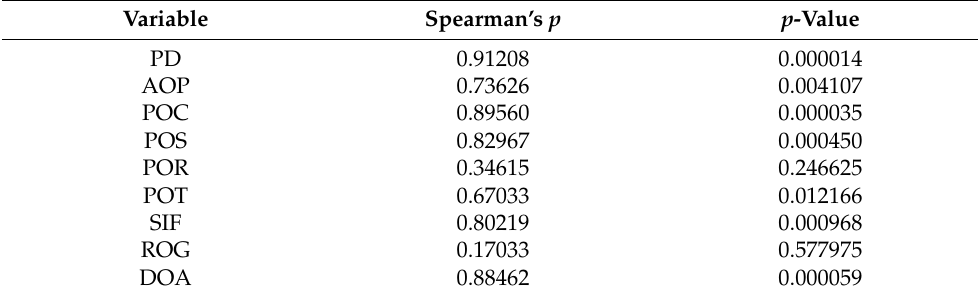
Table 2. Spearman’s correlation results of COVID-19 morbidity rate with the demographic and activity indicators at the county level in Wuhan. PD (population density), AOP (ageing of population), POC (proportion of catering), POS (proportion of shopping), POR (proportion of recreation), POT (proportion of traffic trips), SIF (spatial-interaction frequency), ROG (radius of gyration), and DOA (duration of outside activities).